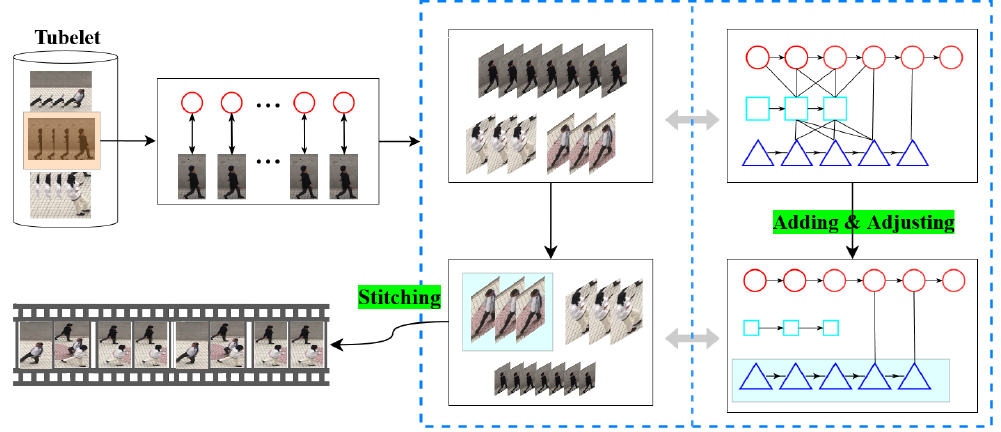
Figure 2. Overview of the adjustment phase in G set with a capacity of P =